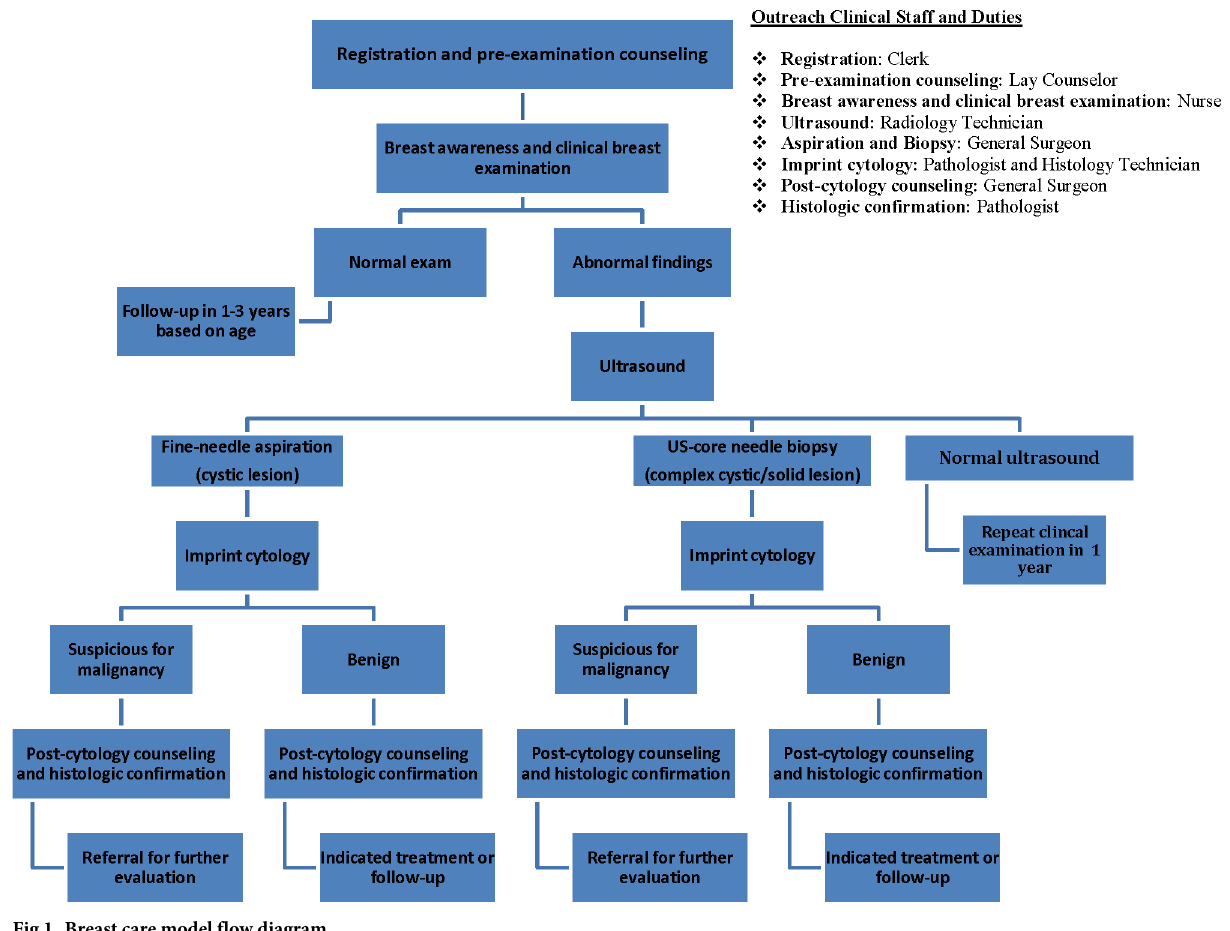
Fig 1. Breast care model flow